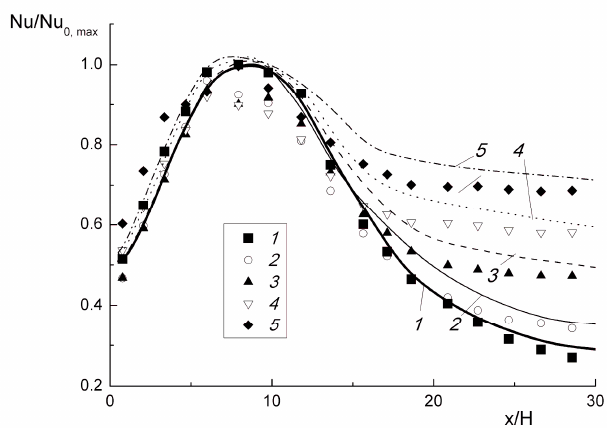
Figure 8. The distributions of heat transfer enhancement ratios along the axial coordinate at Re H = 1.02 × 10 4 . Points and lines are authors’ measurements and computations respectively. d = 1.7 − 2 mm, 2 R 1 = 15 mm, H = 13.5 mm, 2 R 2 = 42 mm, ER = ( R 2 / R 1 ) 2 = 7.84, q W = const = 8.95 kW/m 2 , T 1 = T b 1 = 298 K. 1— β = 0 (one-phase flow), 2— 1.2%, 3— 3.6, 4— 7, 5— 10.1.